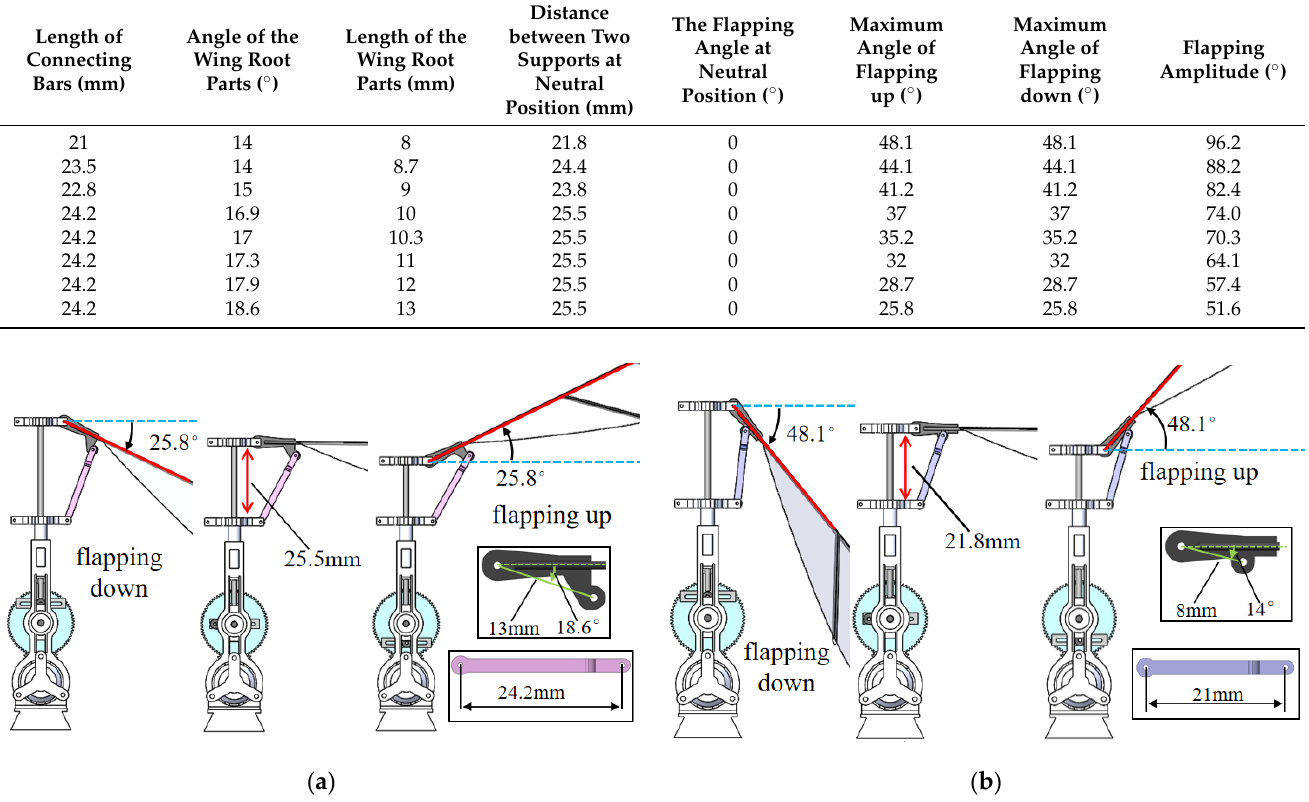
Figure 21. Schematic of the flapping amplitudes: ( a ) Flapping amplitude of 51.6°; ( b ) flapping amplitude of 92.6°.